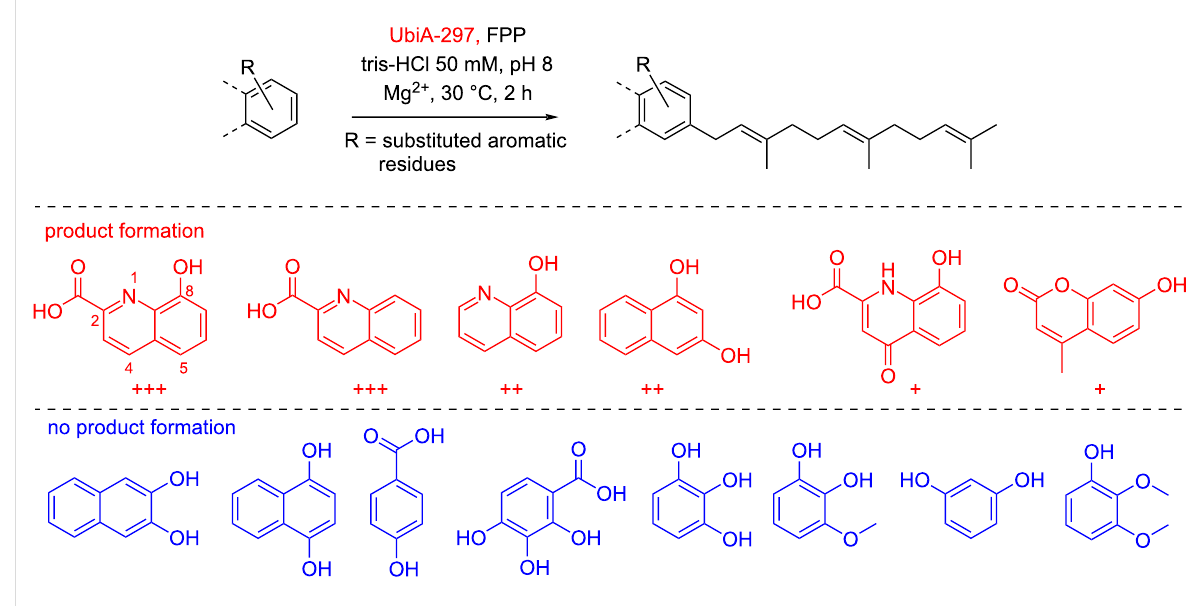
Figure 5: Evaluation of substrate specificity of UbiA-297. Accepted substrates are shown in red, while no product formation was observed for com- pounds colored in blue. HRMS signal intensities and the MS 2 pattern of the farnesylated product served as measure to determine preferred acceptor substrates (ion signal intensity: >10 7 = +++, >10 6 = ++, and >10 5 = +, n = 3) (for comparision assuming equal ionisation